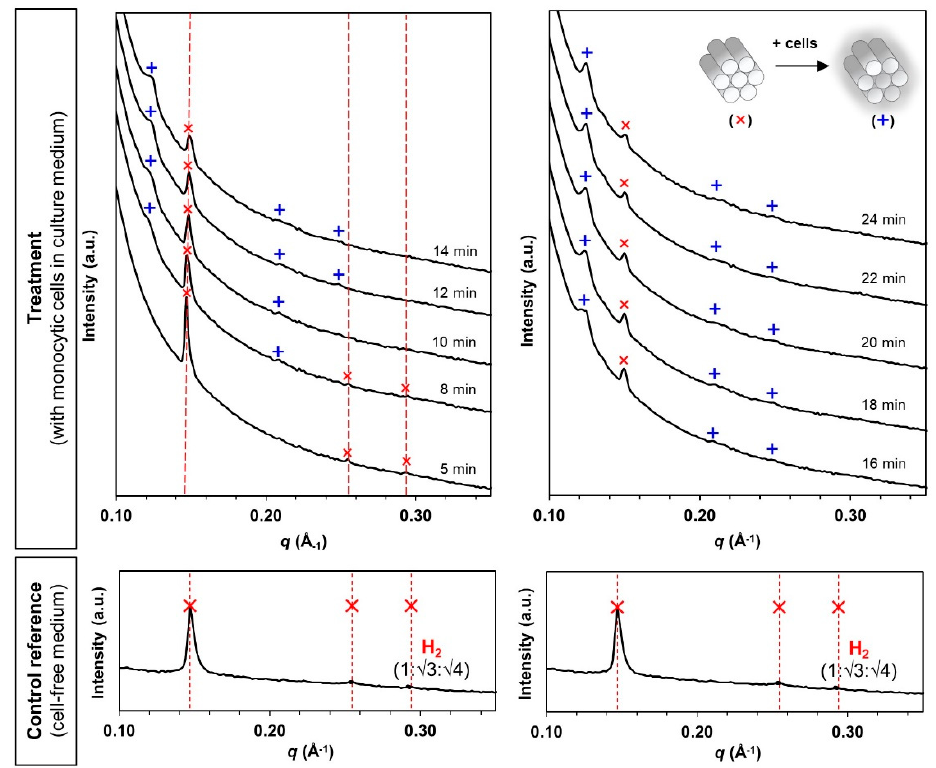
Figure 3. Bio-SAXS profiles of the phytantriol-based hexosomes (H 2 phase) at 1 mg / mL under circulating flow conditions in the absence and presence of human monocytic cells (at 27 ◦ C hutch temperature): original H 2 phase ( × , primary q = 0.147 Å − 1 ) and evolved H 2 phase ( + , primary q = 0.123 Å − 1 ) at Bragg √ √ peak spacing ratios of 1: 3: 4 [Miller indices ( hk ) = (10), (11) and